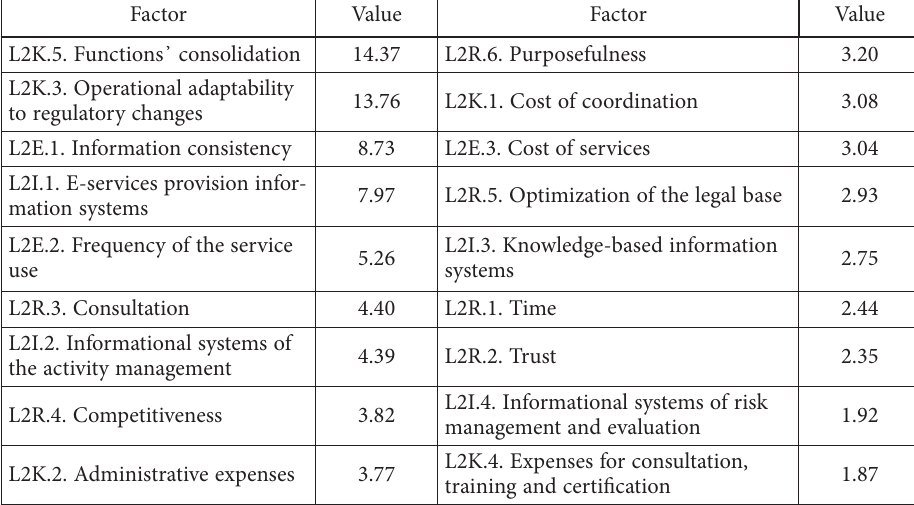
Table 7. The results of the significance of the factors that influence the efficiency of the consolidation of the activities of regulatory institutions while implementing e-government solutions (the results of the expert evaluation by business entities) (created by the authors)